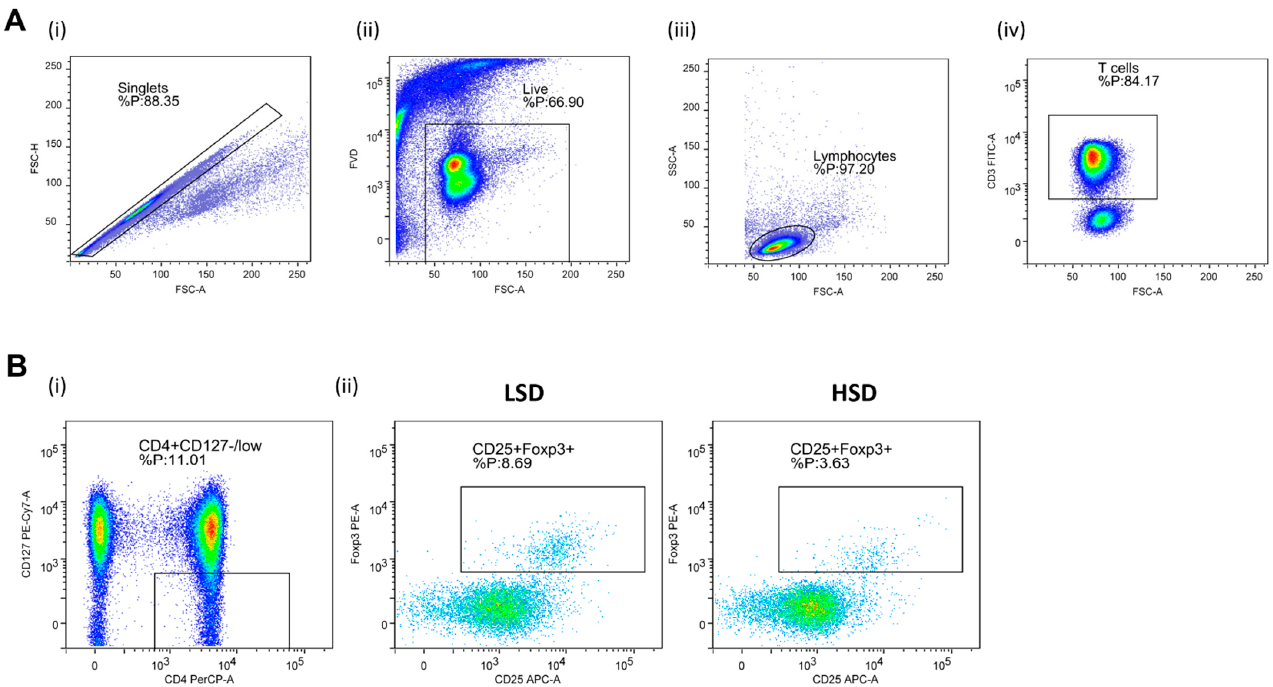
Figure 1. Gating strategy for the assessment of peripheral blood regulatory T cells (Treg) by flow cytometry. Panel ( A ) shows representative dot plots illustrating gating strategy, including exclusion of doublets using forward scatter area (FSC-A) versus forward scatter width (FSC-W) analysis ( A - i ), gating on live cells negative for aminereactive fixable viability dye ( A - ii ), lymphocytes ( A - iii ), and CD3 + T cells ( A - iv ). Next, total CD25 and Foxp3, expressing T cells among CD4 + CD127 low population, were analyzed (Panel ( B )). ( B - i ) shows representative gating strategy, ( B - ii ) representative samples from LS and HS protocol. FlowLogic software was used for data analysis and illustration.